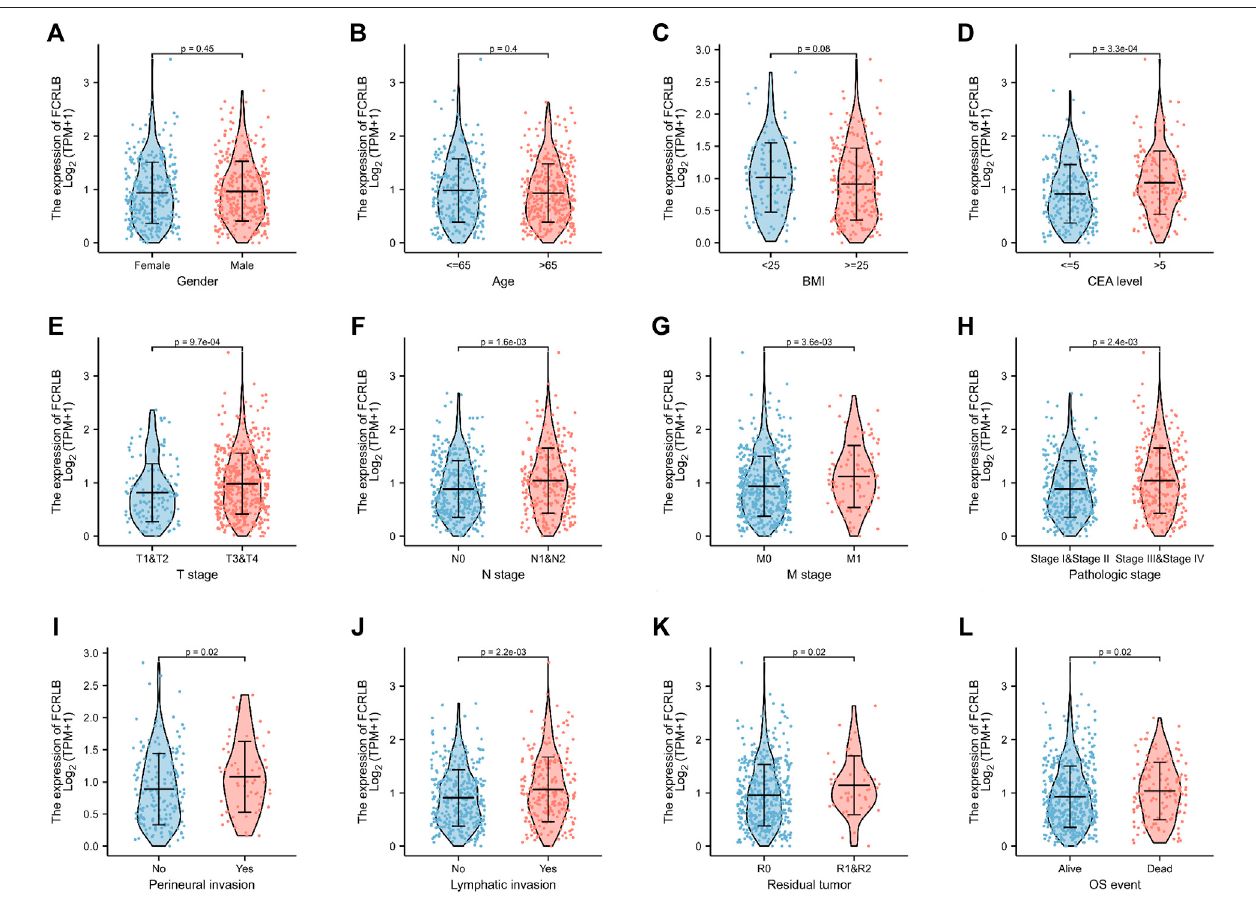
FIGURE 3| The relationship between FCRLB expression and clinicopathological characteristics in the TCGACRC cohort. (A – I) The FCRLB was highly expressed in CRC groups with higher serum CEA level (D) , higher T stage (E) , higher N stage group (F) , higher N stage group (G) , more advanced AJCC stage (H) ， perineural invasion (I) , lymphatic invasion (J) , R1/R2 resection (K) , more unfavorable OS event (L) . However, no signi fi cant difference in expression of FCRLB was detected in different gender groups (A) , different age groups (B) and different BMI groups (C) . p -values were noted in each fi gure.